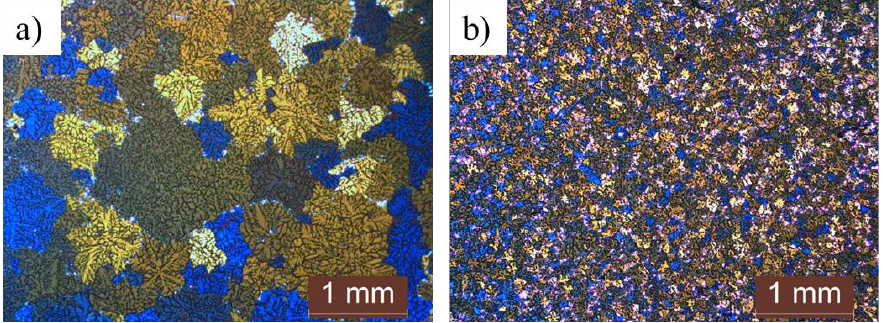
Figure 2. Microstructures of the as - cast samples: ( a ) Commercial - purity AZ91 alloy; ( b ) High - purity AZ91 alloy.